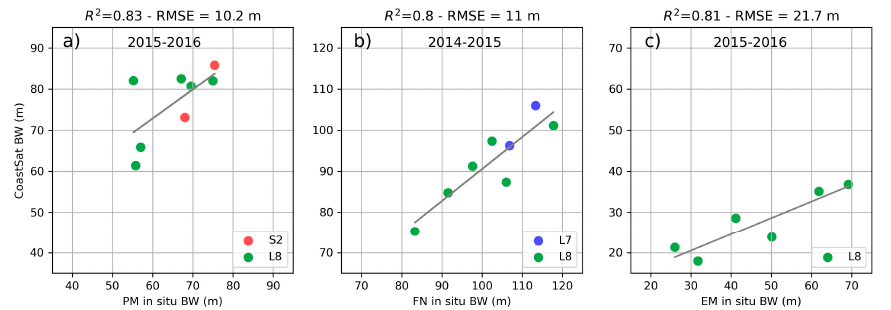
Figure 3. Scatter plots between BW inferred from beach surveys and satellites at ( a ) PM, ( b ) FN, and ( c ) EM. Correlation coefficients (R 2 ), RMSE (root mean square error), and satellite missions are indicated. Best linear fit is also included (black